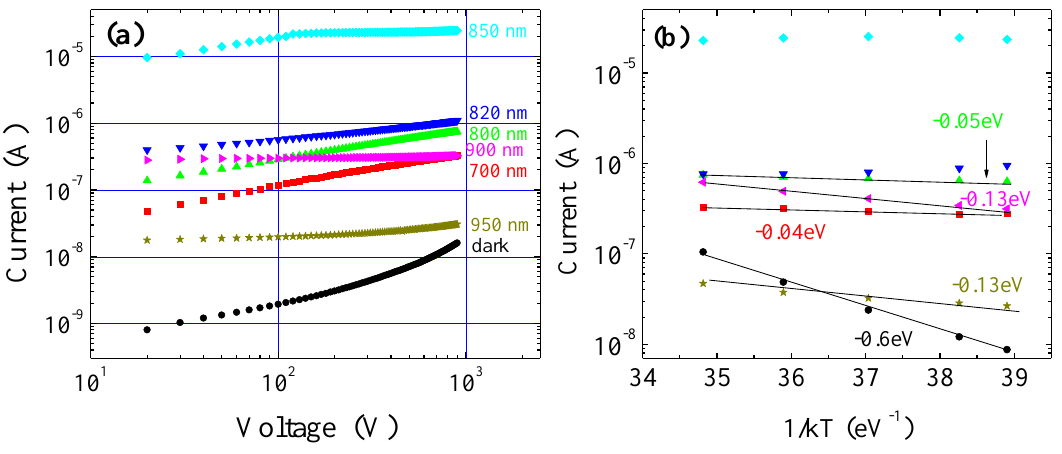
Figure 4. Optical irradiation on anode side: ( a ) photocurrent vs . voltage characteristics at different wavelengths, and under dark, T = 25 °C. ( b ) Thermal activation plot of photocurrent (and dark) at 600 V. Activation energies are also reported for each wavelength (same symbols and colours as ( a )). At 820 and 850 nm a negligible activation energy is